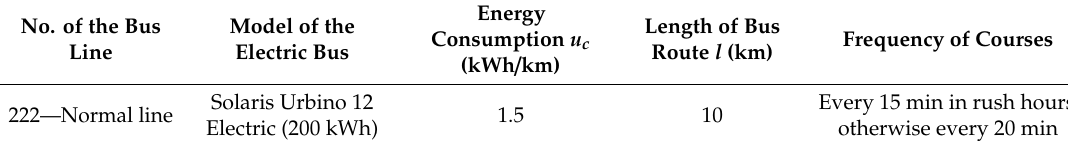
Table 3. Functional data of bus line No.